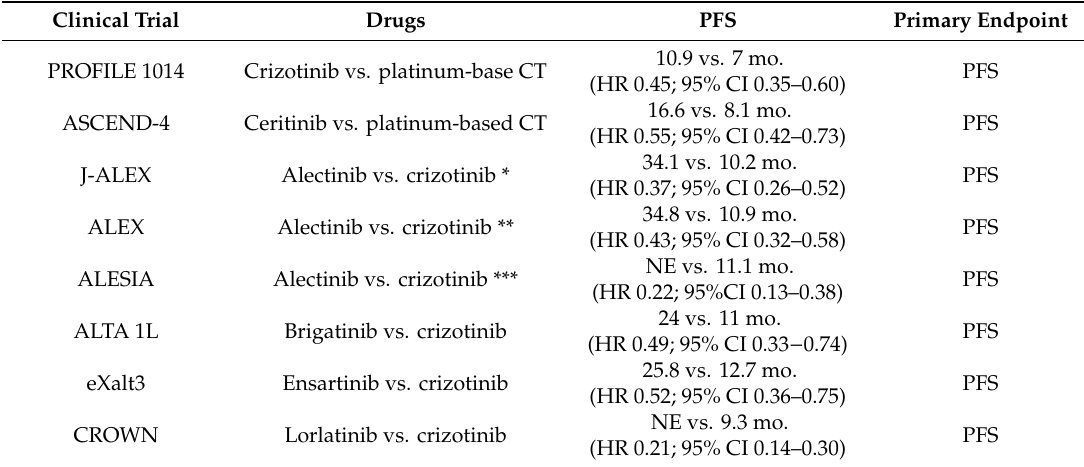
Table 1. Main phase III trials evaluating anaplastic lymphoma kinase (ALK)-inhibitors in the first-line setting ALK-positive non-small cell lung cancer